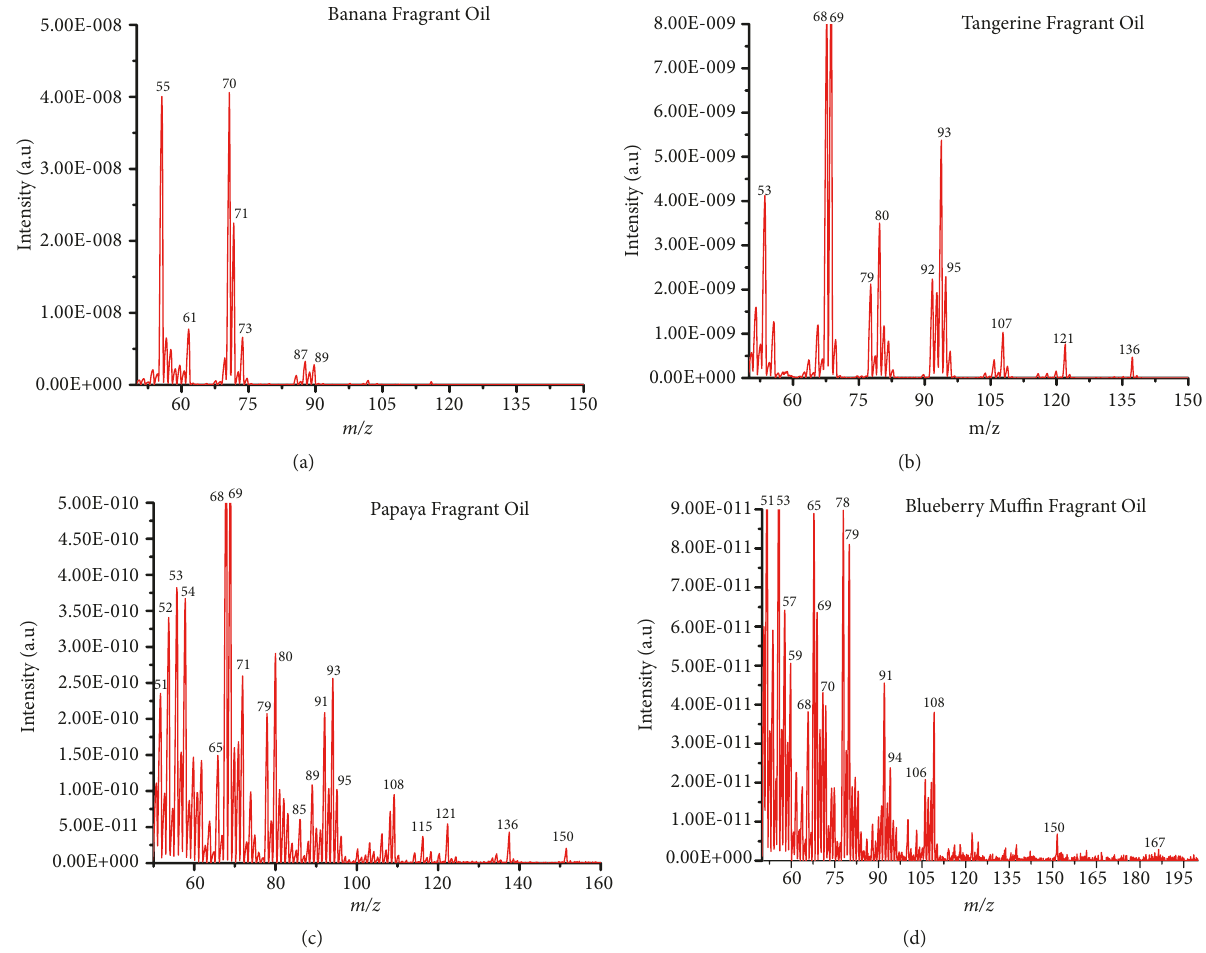
Figure 5: Electron impact ionization mass spectrum for essential fragrant oils analyzed using a direct membrane probe coupled to portable mass spectrometer. (a) banana, (b) tangerine, (c) papaya, and (d) blueberry muffin. Approx. 5 𝜇 L of each was deposited in the flask and left for 2 hours forming a headspace vapor and analyzed for 2 minutes with 70 eV EI